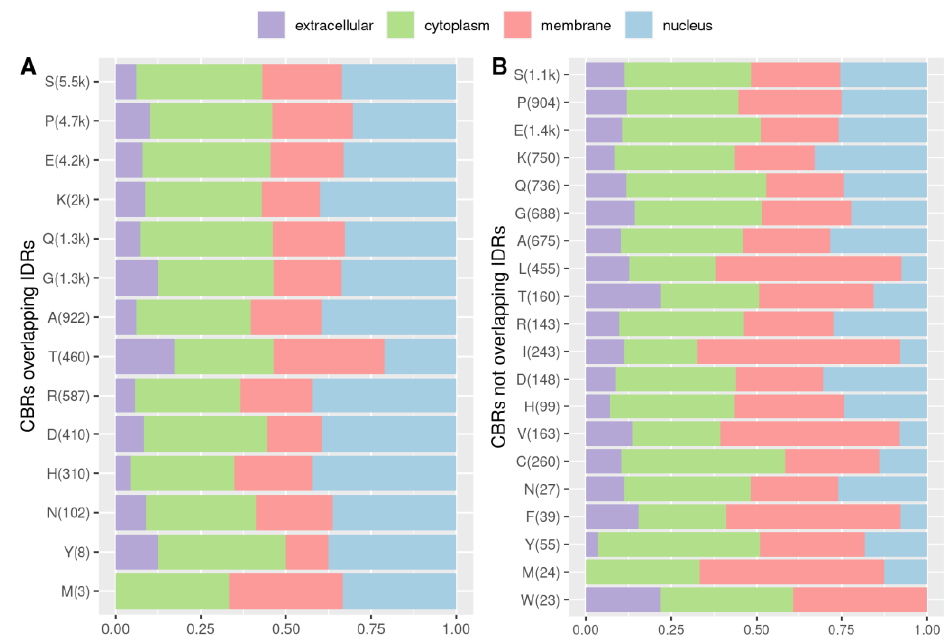
Figure 7. CBRs in cellular locations. ( A ) CBRs overlapping IDRs. ( B ) CBRs not overlapping IDRs. Locations were obtained from Gene Ontology annotations retrieved with QuickGO (see Methods for details). Number of CBRs for each category is indicated in brackets (k means thousands).